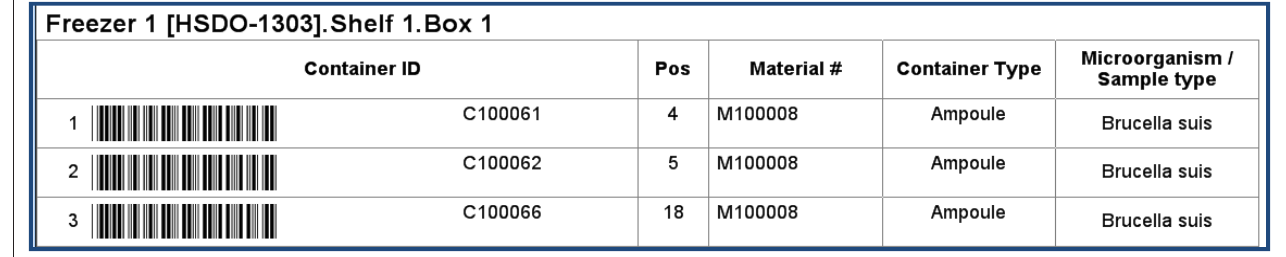
FIGURE 6: Freezer content report.